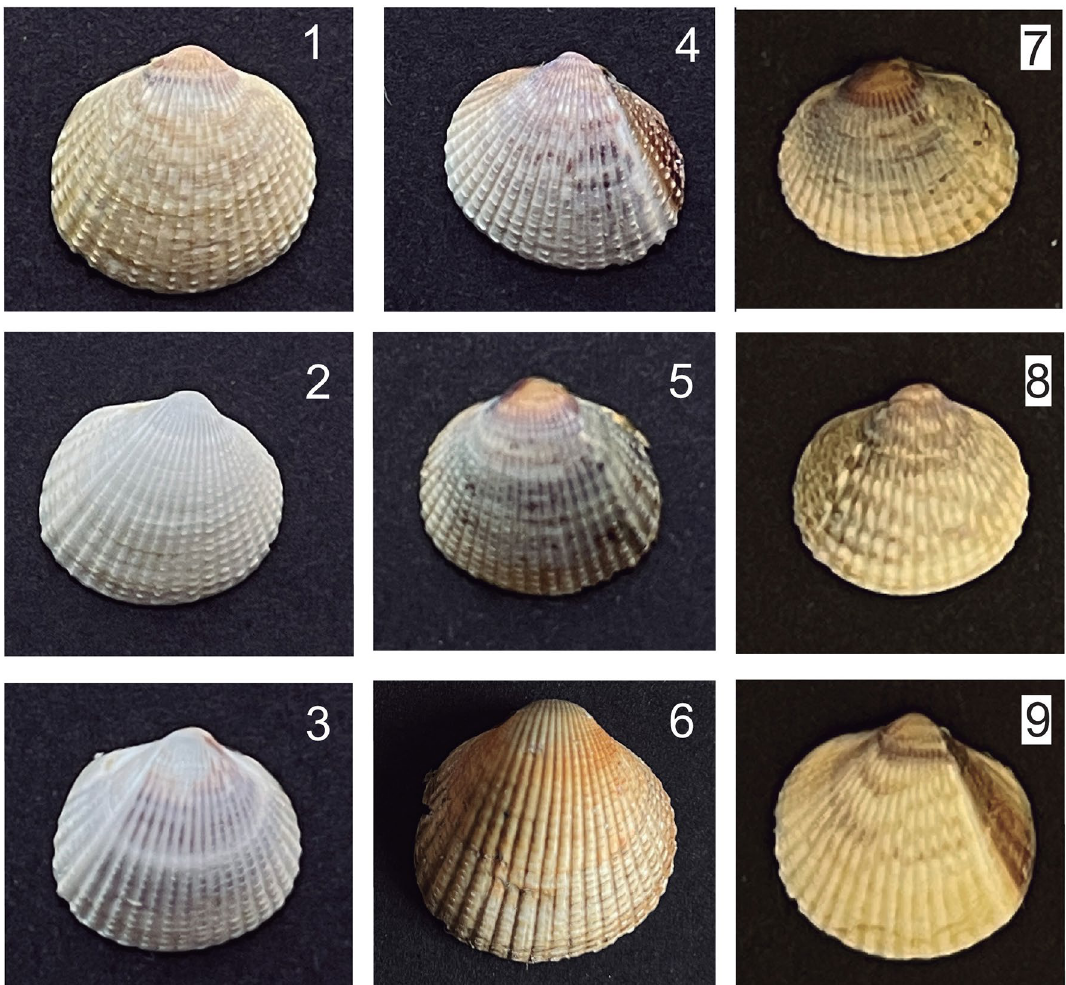
Figure 1. Representative individuals for each color and pattern identified in shells of C. edule from Northeast Atlantic. From up to down and left to right: color phenotypes yellow (1), white (2), gray (3), brown (4), black (5), orange (6), and shell patterns circle (7), line (8) and stripe